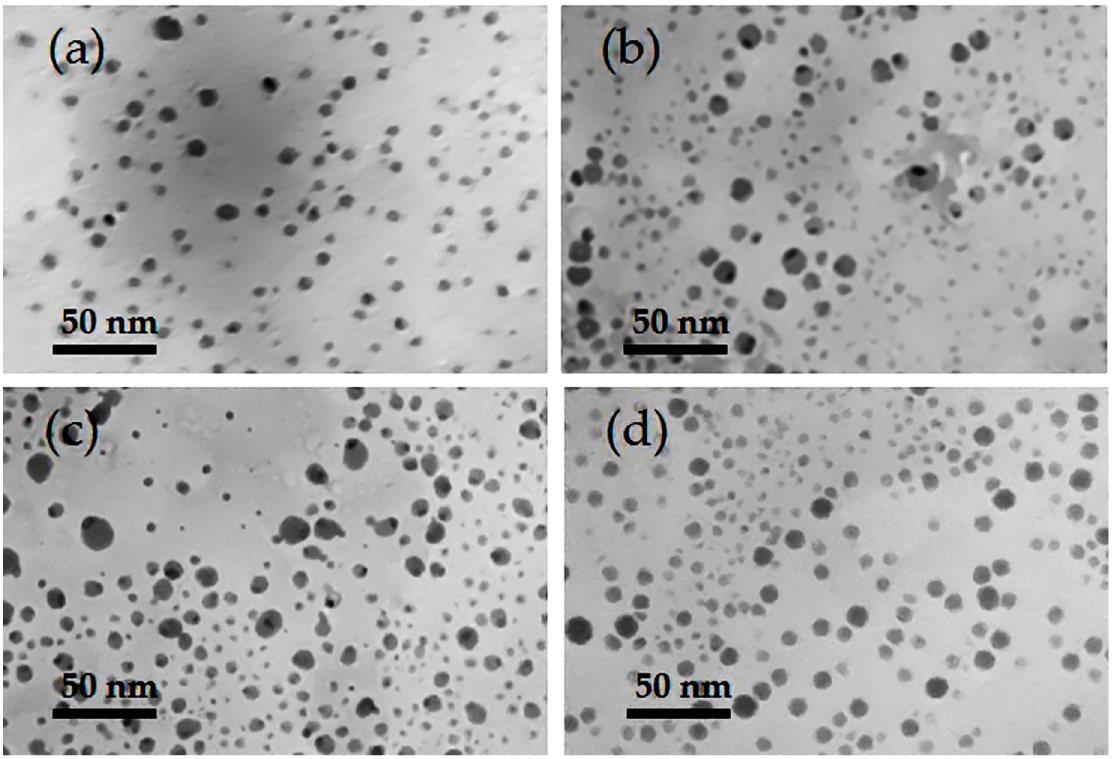
Figure 4. TEM micrographs of AgNPs produced by: ( a ) WT-1.250 mM; ( b ) WT-0.625 mM; ( c ) CWD-1.250 mM; and ( d ) CWD-0.625 mM.